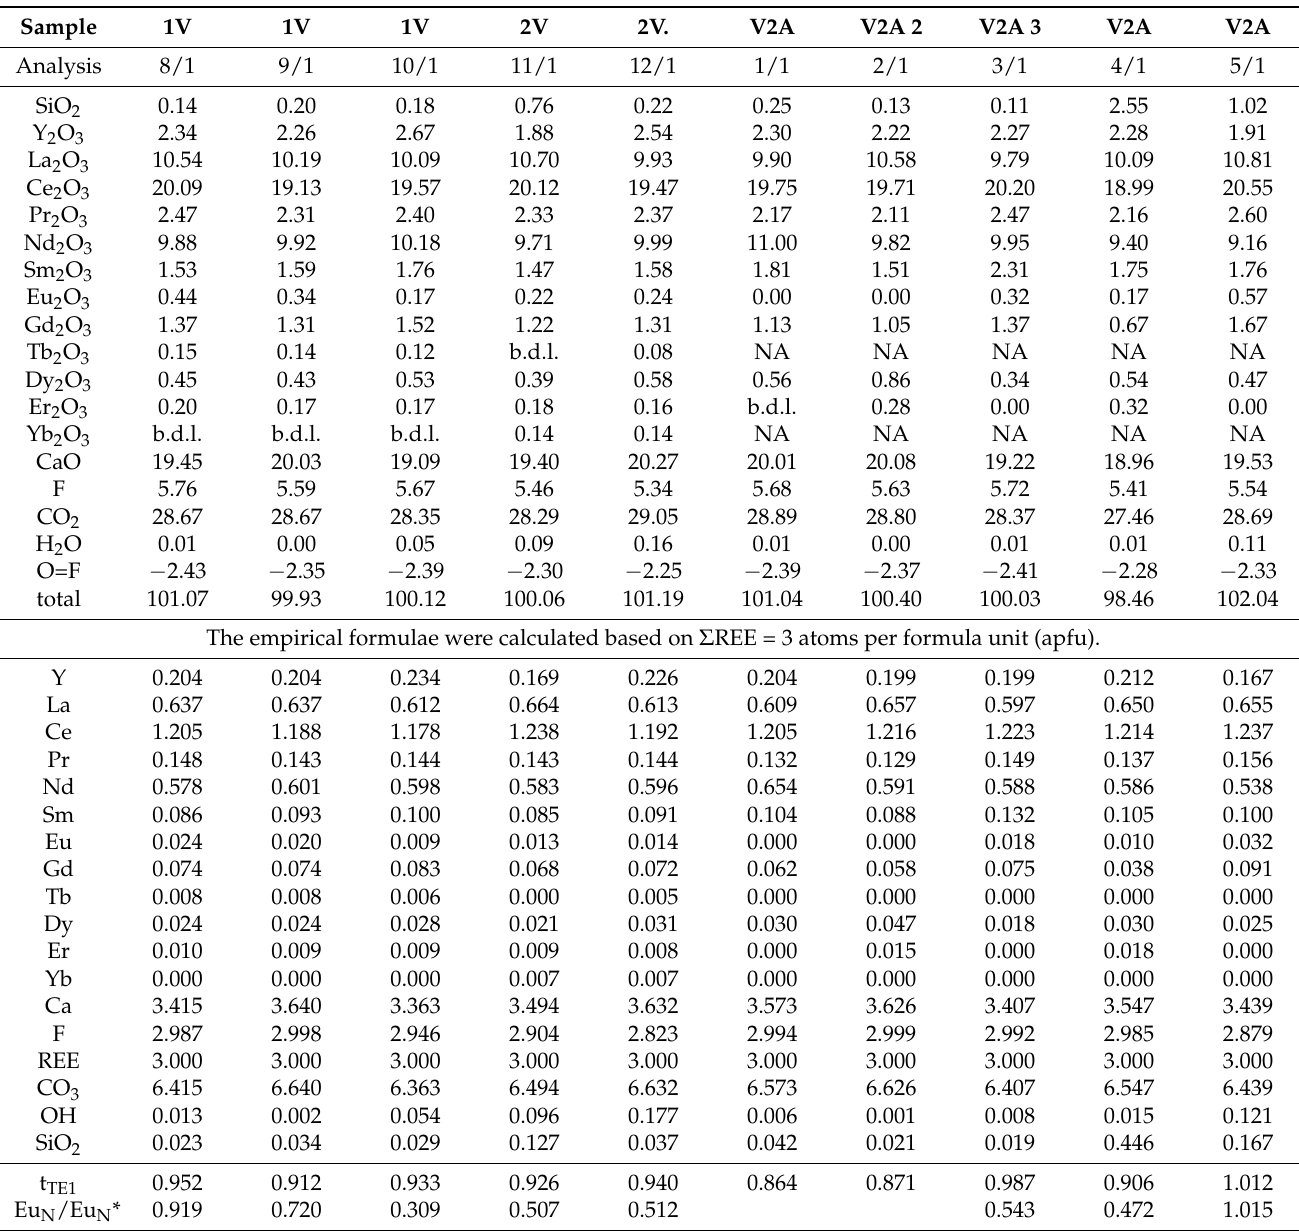
Table 3. Chemical composition of synchysite (EMPA). Concentrations are expressed in